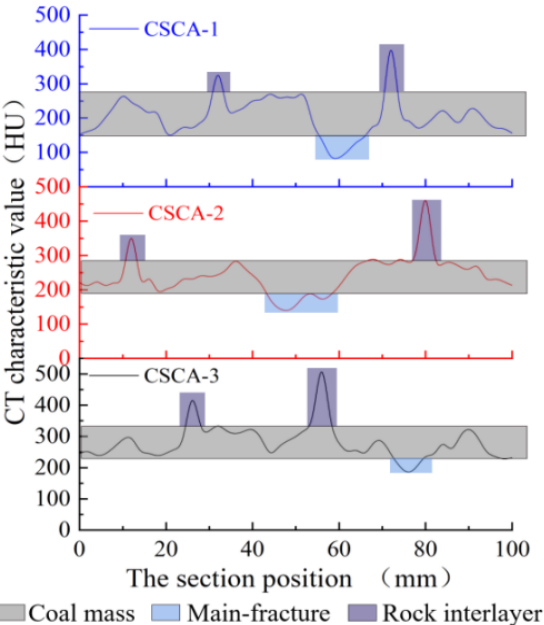
Figure 3. Average CT number of coal mass fractures.